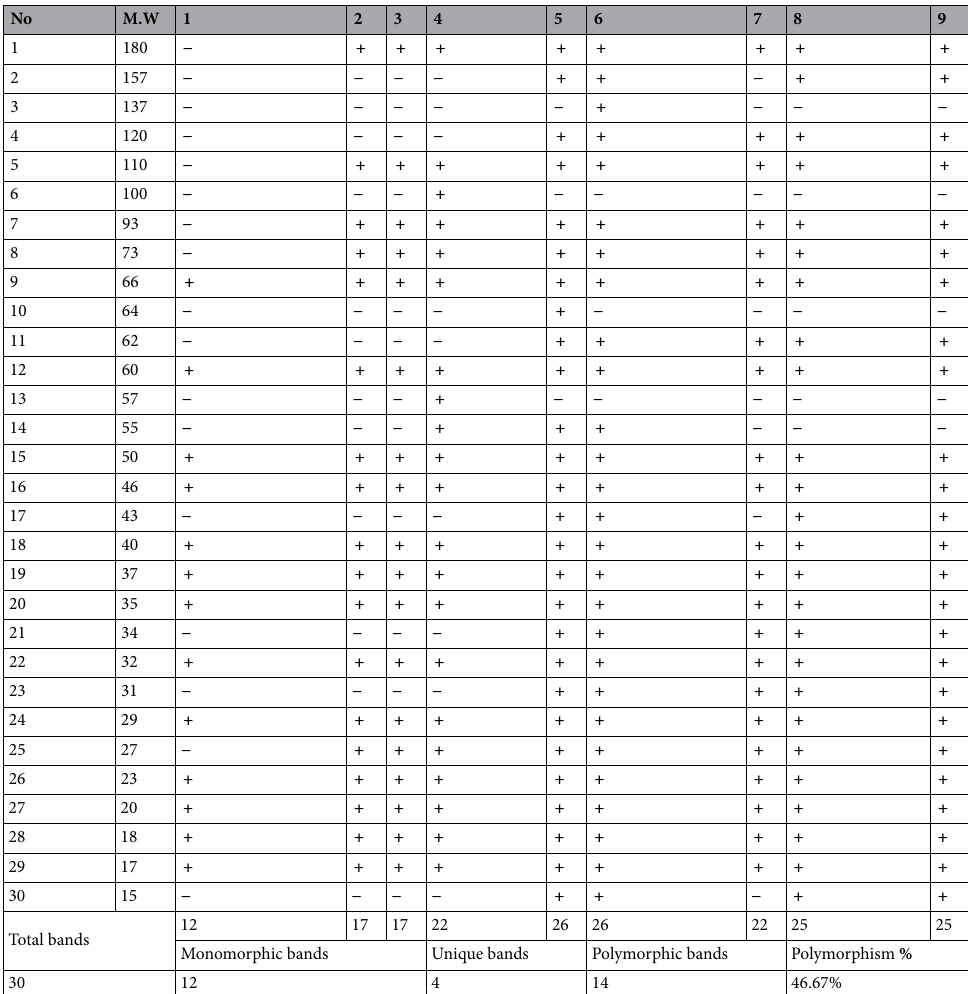
Table 2. Effect of L-cysteine on protein profile in leaves of salt-stressed flax plants. Where, M, Protein marker; 1, Control; 2, 0.8 mM Cys; 2, 1.6 mM Cys; 4, 50 mM NaCl; 5, 50 mM NaCl + 0.8 mM Cys; 6, 50